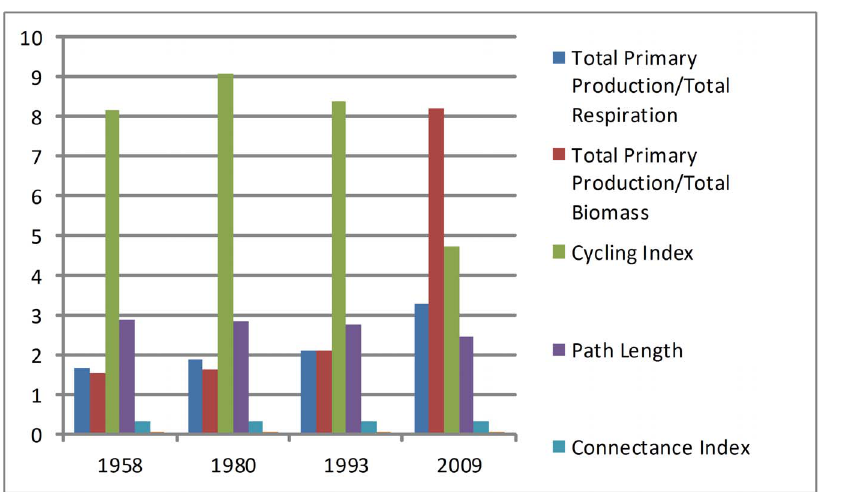
Figure 6. Food web structure in 1958, 1980, 1993, and 2009. Several parameters on food web structure changed sharply from 1958 to 2009. Total primary production and total respiration (TPP/TR) increased by 96.60% in the past 50 years, whereas the cycling index decreased by 41.96%.